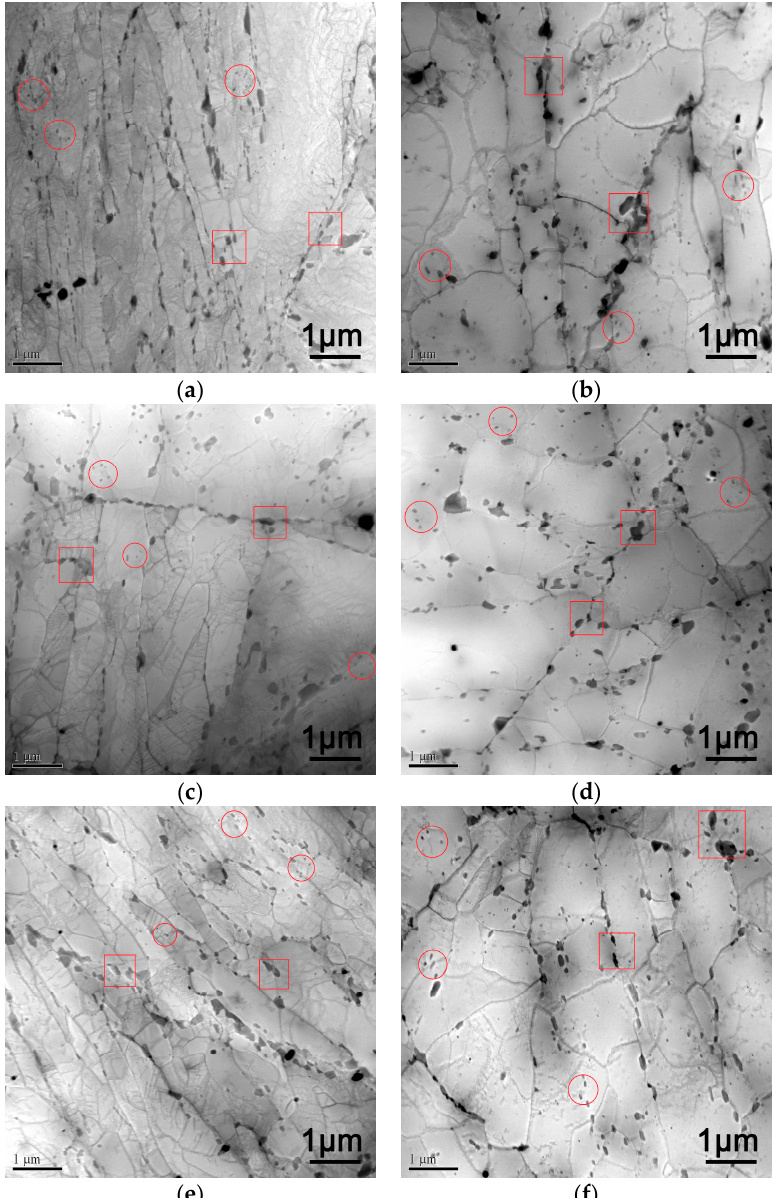
Figure 3. Transmission electron micrographs of the specimens as ‐ tempered and creep ‐ tested under 150 MPa at 873 K (the coarser precipitates, such as those marked by a square, are M 23 C 6 ‐ type, while the finer ones, such as those marked by a circle are MX ‐ type): ( a ) undoped steel as tempered; ( b ) undoped steel after creep test; ( c ) Sb ‐ doped steel as tempered; ( d ) Sb ‐ doped steel after creep test; ( e ) Sb+Ce ‐ dopedsteel as tempered; and ( f ) Sb+Ce ‐ doped steel after creep test.